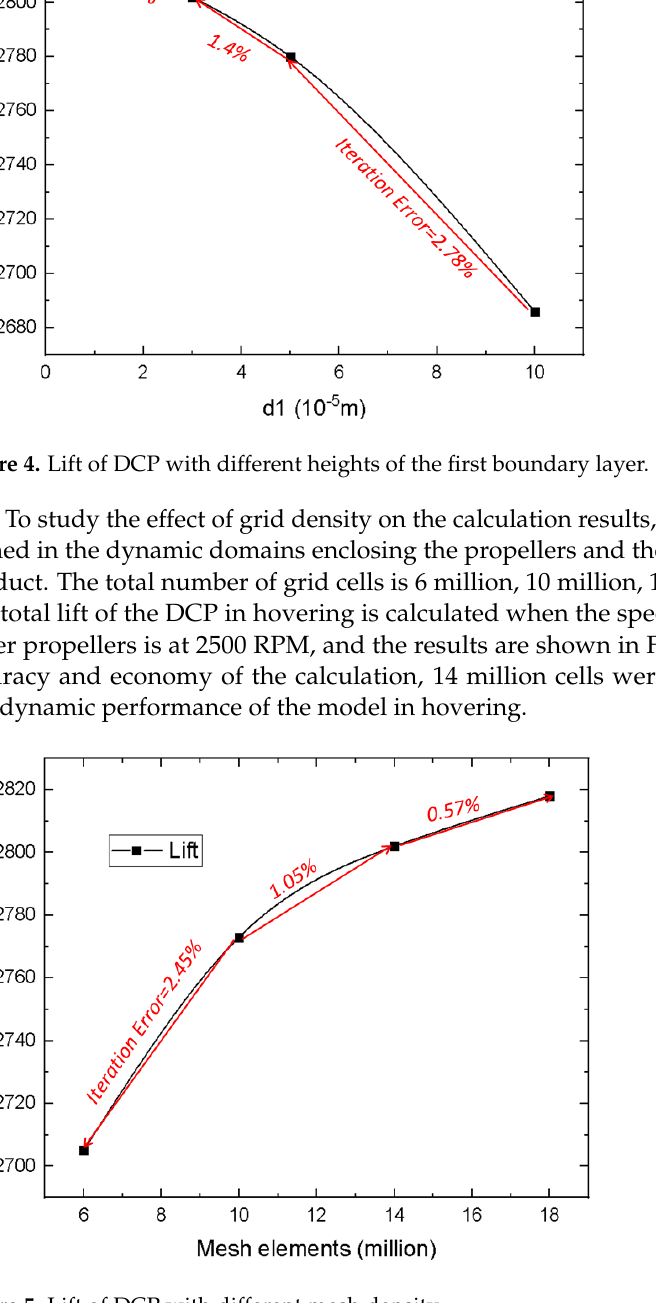
Figure 5. Lift of DCP with different mesh density. According to the grid irrelevance analysis, a grid with 14 million cells and the height of the first layer of boundary layers of 0.00003 m is enough for accurate calculation. The final number of boundary layer layers of both the duct and the propeller is 12, the wall growth rate of the boundary layer grid is 1.2, and the value of the grid wall y+ is 1. The grid of the DCP is shown in Figure